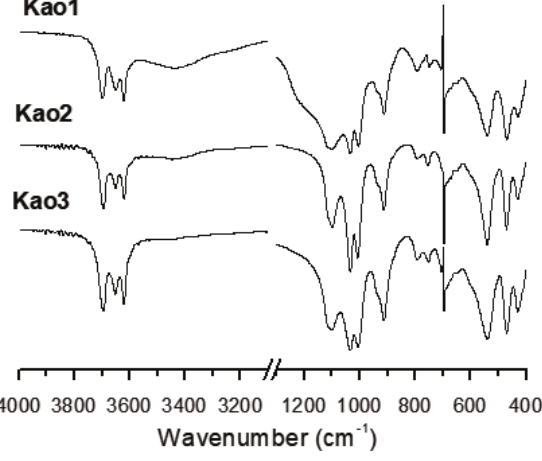
Figure 2 - FT-IR of the